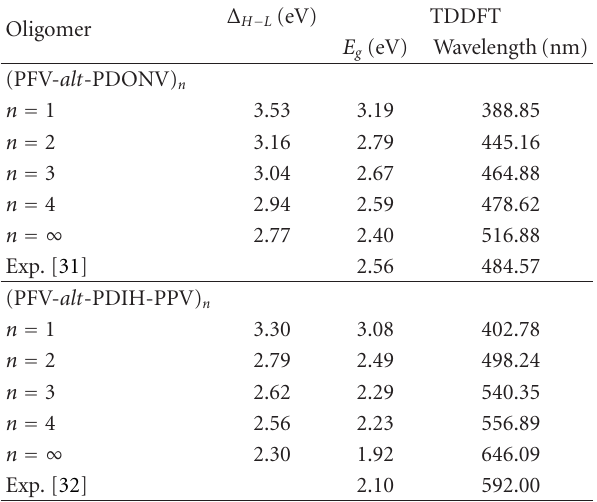
Table 2: The HOMO-LUMO gaps ( (cid:2) H − L ) by B3LYP and the lowest excitation energies ( E g ) by TDDFT of PFV- alt -PDONV and PFV- alt -PDIH-PPV ( n = 1–4).